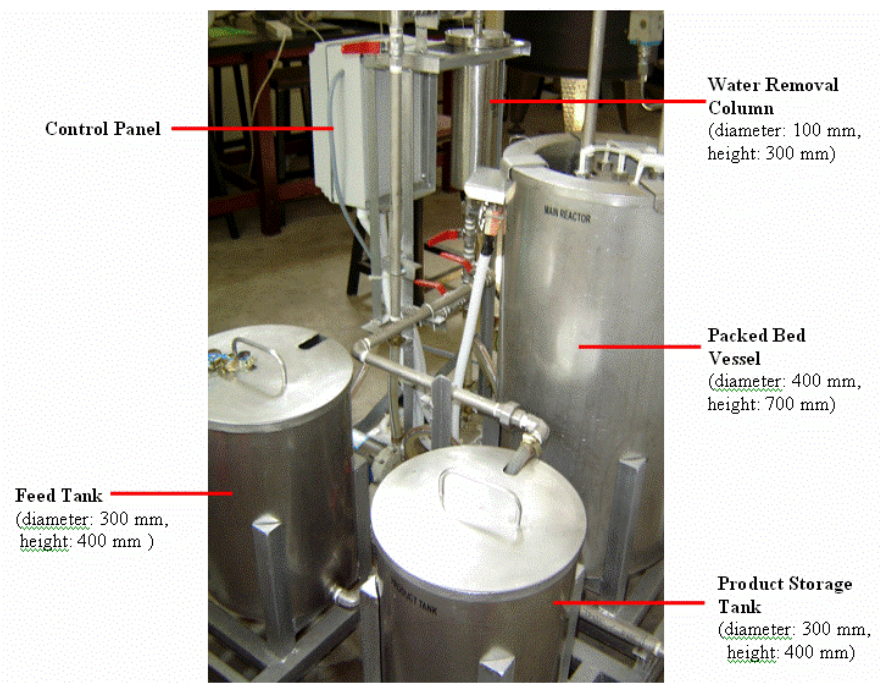
FIGURE 2. A photograph of the in-house-designed PBR used in this study. The vessels are built from stainless steel (SS